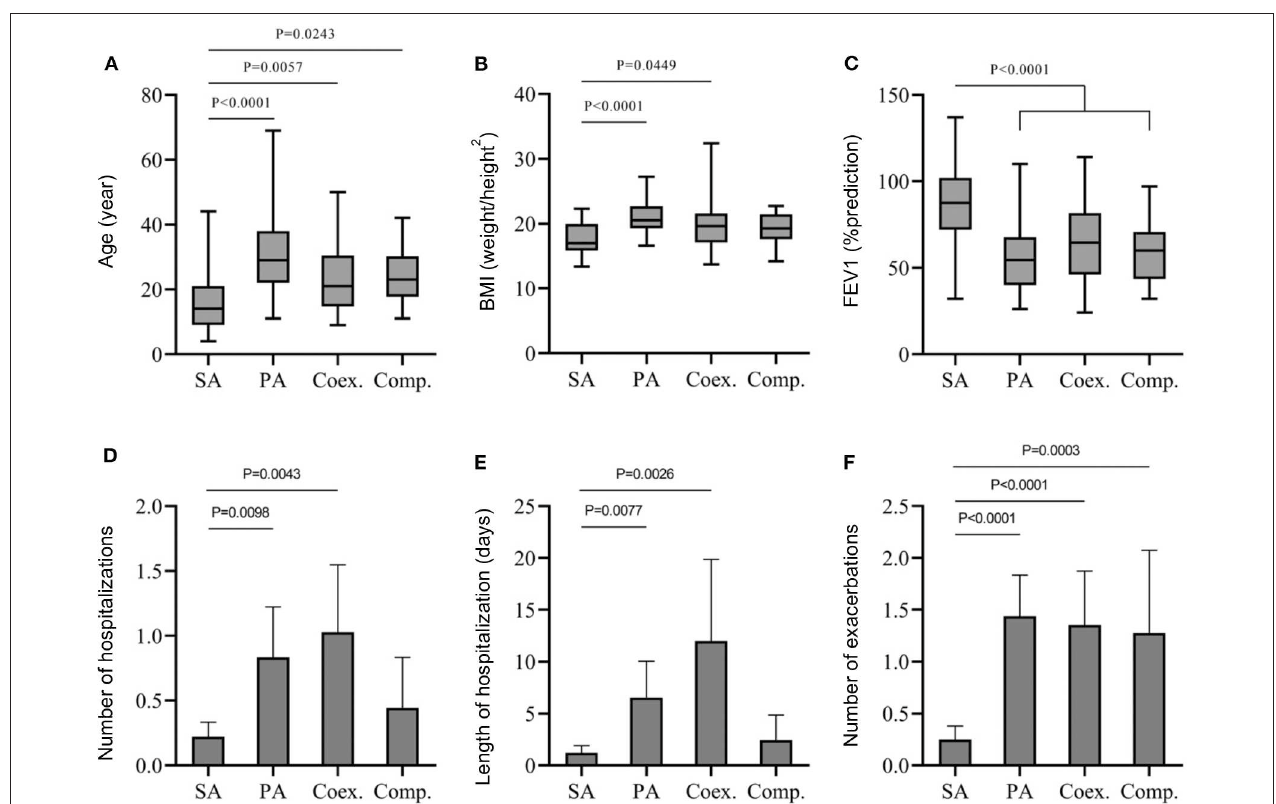
FIGURE 1 | Comparison between SA mono-infected (SA), PA mono-infected (PA) and co-infected groups in competition (Comp) or in coexistence (Coex) for age mean (A) , BMI (B) , FEV1 (C) , number of hospitalization (D) , length of hospitalization (E) , and number of exarcerbations (F) . A Mann-Whitney Wilcoxon non-parametric test corrected by a Bonferroni method was used.